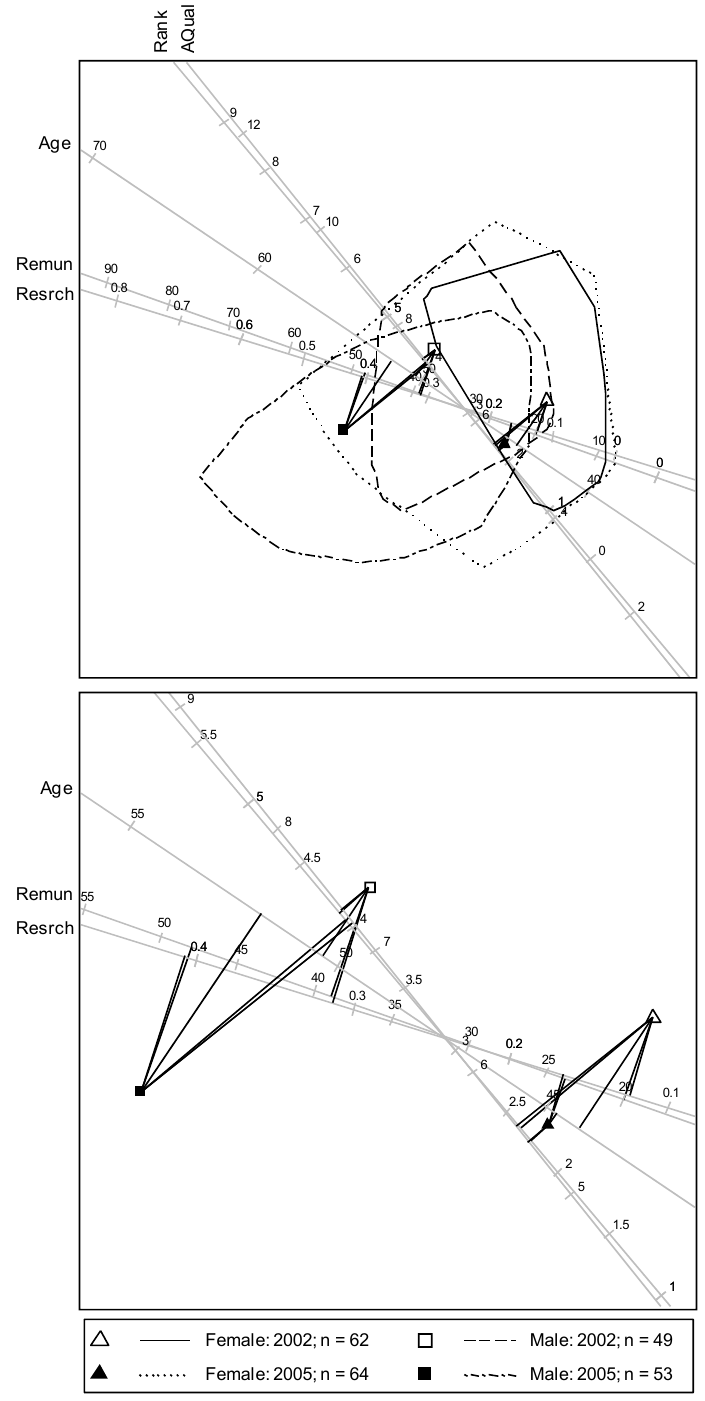
Figure 8: CVA biplot separating C1 staff in the Faculty of Health Sciences according to the 2002 Female, 2005 Female, 2002 Male and 2005 Male subgroups. Plotting of data points is suppressed. The upper panel shows the biplot overlaid with 90% bags. The bottom panel shows the group means on a large scale together with perpendicular lines from each group mean to the five axes for determining the biplot predictions of the different